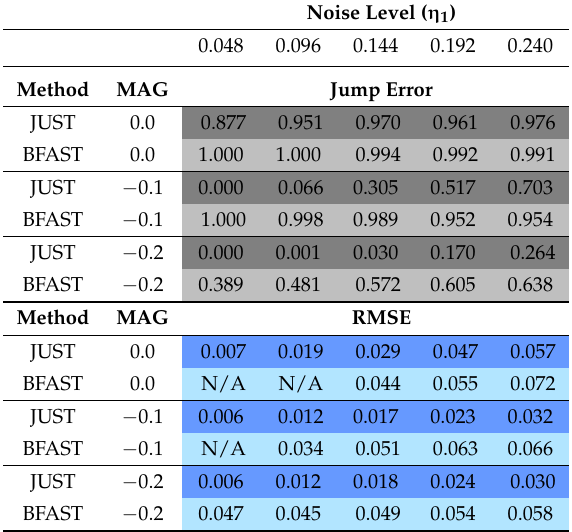
Table 4. Comparison between JUST and BFAST for the time series simulated by the seasonal component given in Equation (7) with trend coefficients given in Table 3 and added noise. N/A means no answer. Please note that in this example the jump (break) with zero magnitude has positive